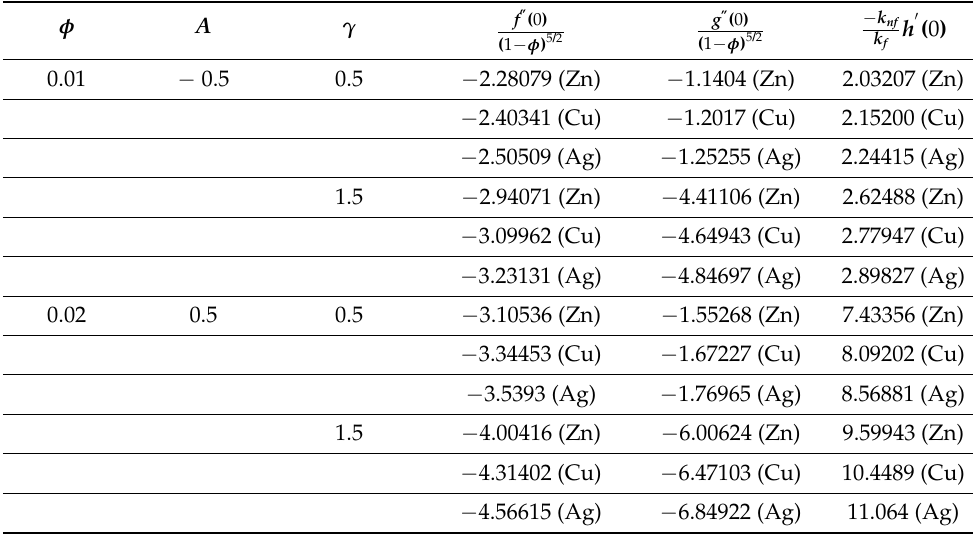
Table 4. Numerical outcomes for skin frictions ( C fx , C fy ) and Nusselt number Nu x from the current